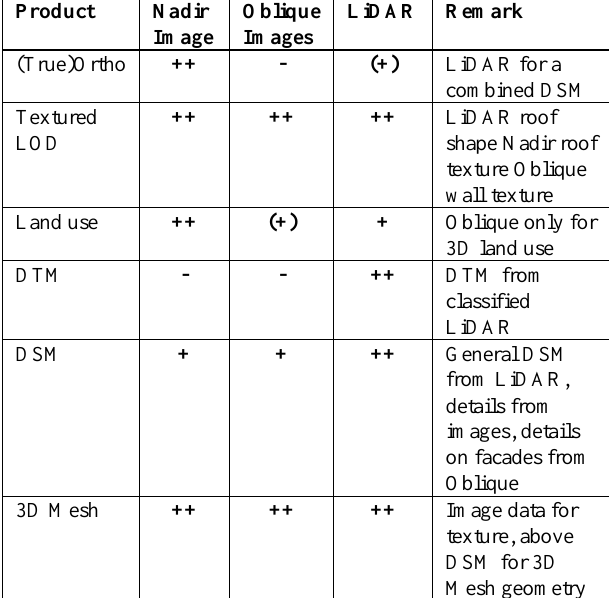
Figure 12: Automatic result of 3D Mesh, produced by Melown